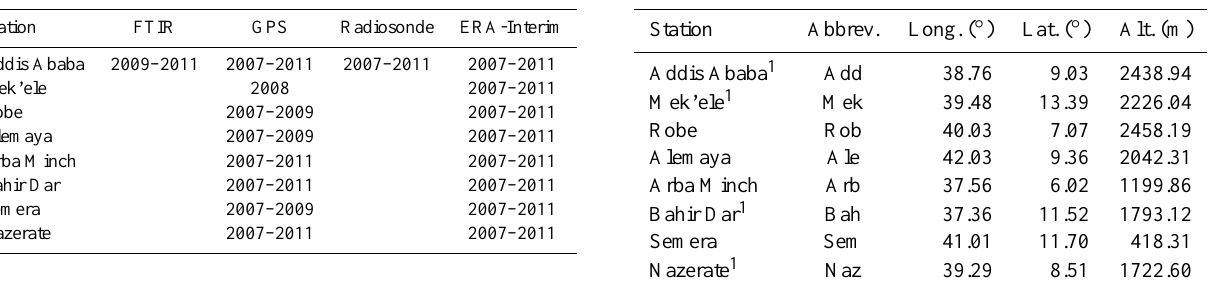
Table 2. The observation periods covered in the study (see also Fig. 4 for data gaps during the period).